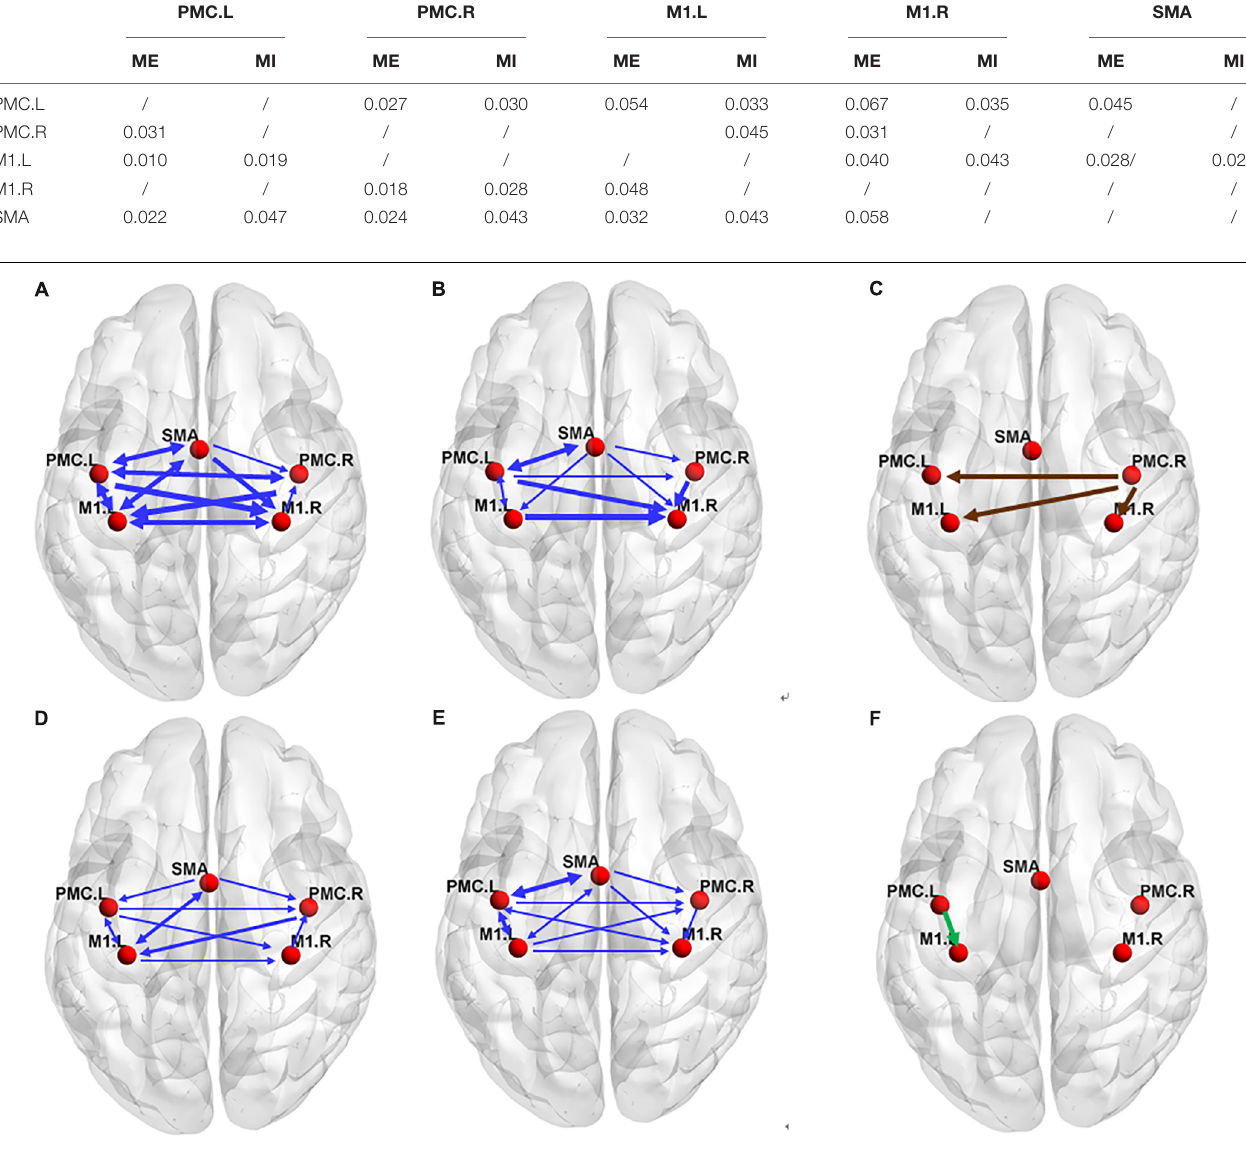
FIGURE 3 | The effective connectivity networks during motor execution (ME) in the older (A) and young group (B) and two-sample statistical results (C) . Effective connectivity networks during motor imagery (MI) in the older (D) and young group (E) and two-sample statistical results (F) . The thickness of the lines is proportional to the connection strength. The connections were tested with non-parametric statistical analyses using Wilcoxon signed rank test and corrected for multiple comparisons (FDR, p <